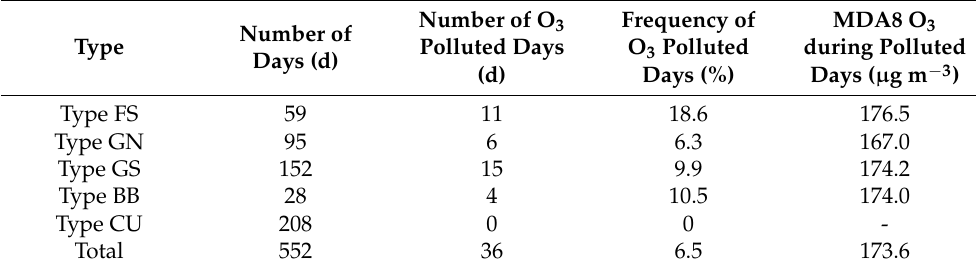
Table 2. Number of days and the O 3 concentrations for O 3 pollution in PT during spring under different SWPs from 2015 to 2020.